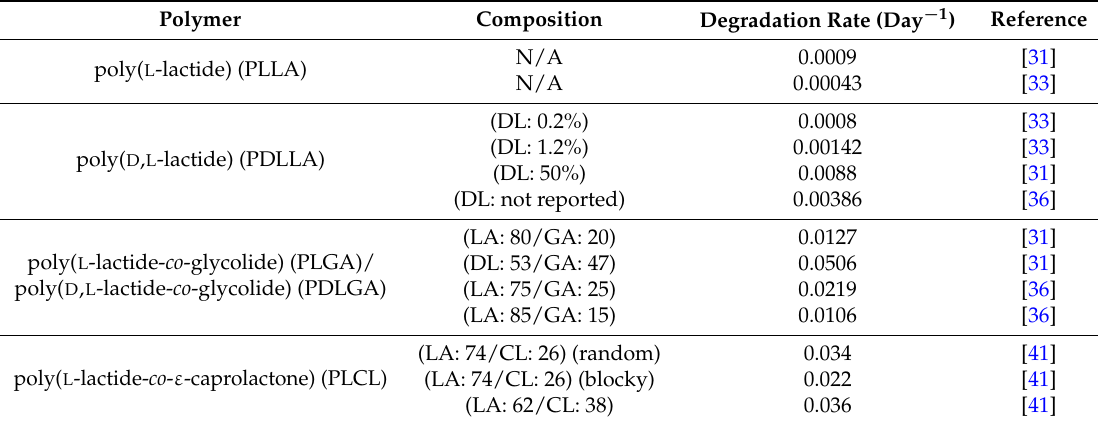
Table 2. Some of the reported degradation rates for the poly( α -hydroxyacids) considered herein, (DL: D -lactide; LA: L -lactide; GA: Glycolide; CL: Caprolactone). Polymer Composition Degradation Rate (Day − 1 ) Reference N/A 0.0009 [31] poly( L -lactide) (PLLA) N/A 0.00043 [33] poly( D , L -lactide)